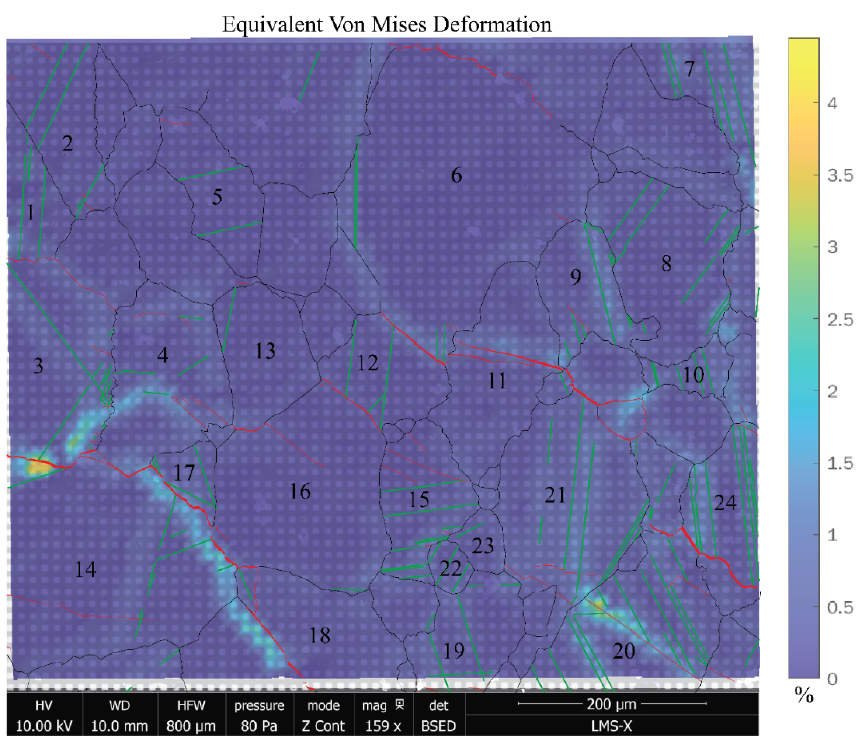
Figure 7. Map of the percentage of deformation at Step 6 of the deformation superimposed on the grain boundaries (in black), fractures (in red) and twin planes (in green).